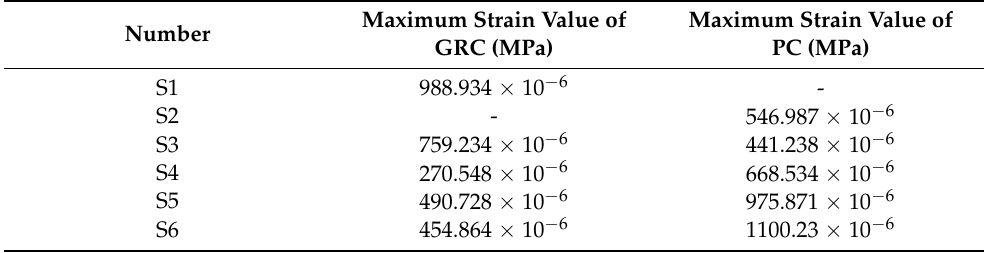
Table 6. Maximum strain values of the GRC and PC layers for each group of wall panels.